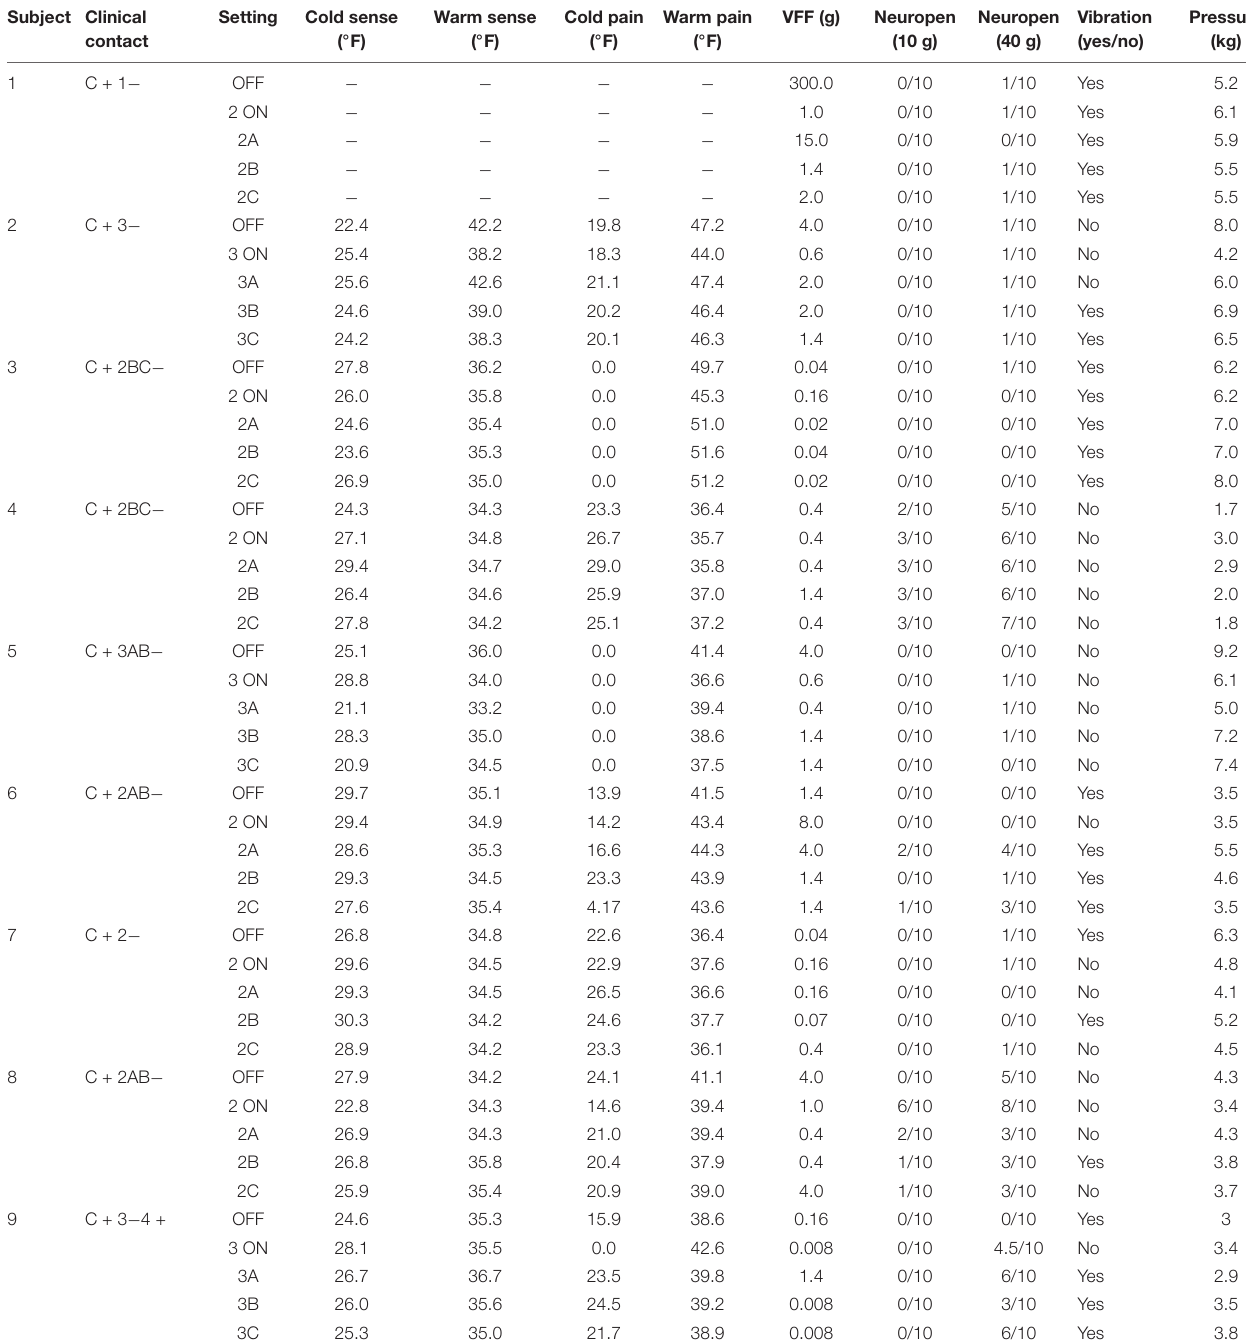
TABLE 3 | Results of quantitative sensory